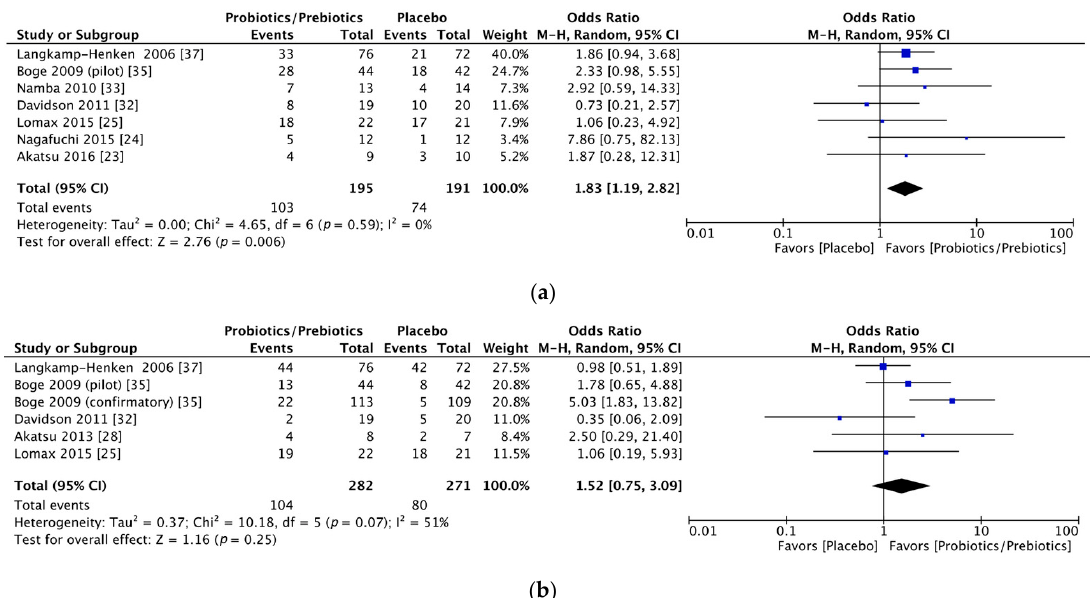
Figure 2. Forest plots of seroprotection and seroconversion rate of H1N1 strain. ( a ) Forest plot of seroprotection rate of H1N1 strain; ( b ) Forest plot of seroconversion rate of H1N1 strain. The bold data represents total participants of all included studies and the Odds ratio (OR) between the probiotics/prebiotics group and the placebo group. The diamond stands for the pooled OR. Weights are from random-effects model. CI: confidence interval.